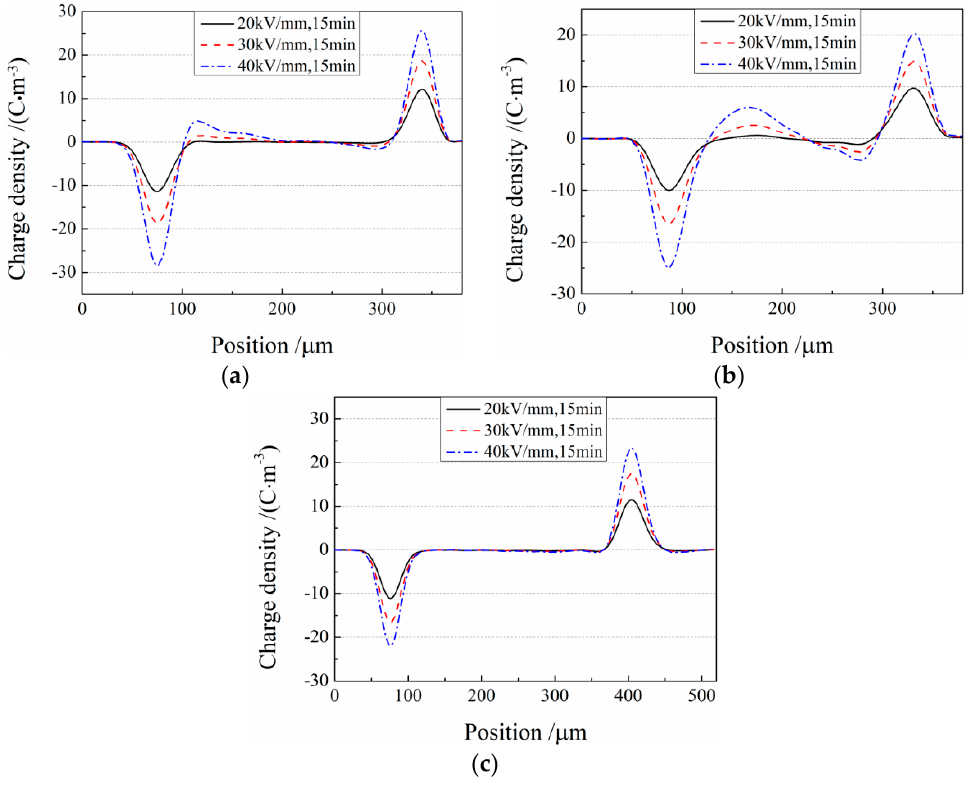
Figure 6. Space charge distributions of ( a ) iPP, ( b ) iPP/SEBS, and ( c ) cPP- g -MAH/iPP/SEBS after polarization by the direct-current (DC) electric field of 20, 30, and 40 kV/mm for 15 min.